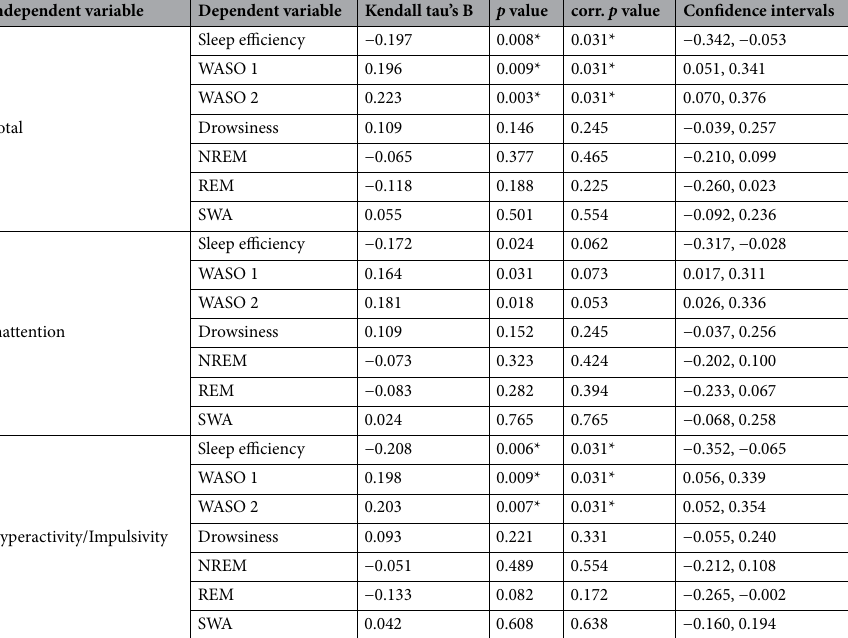
Independent variable